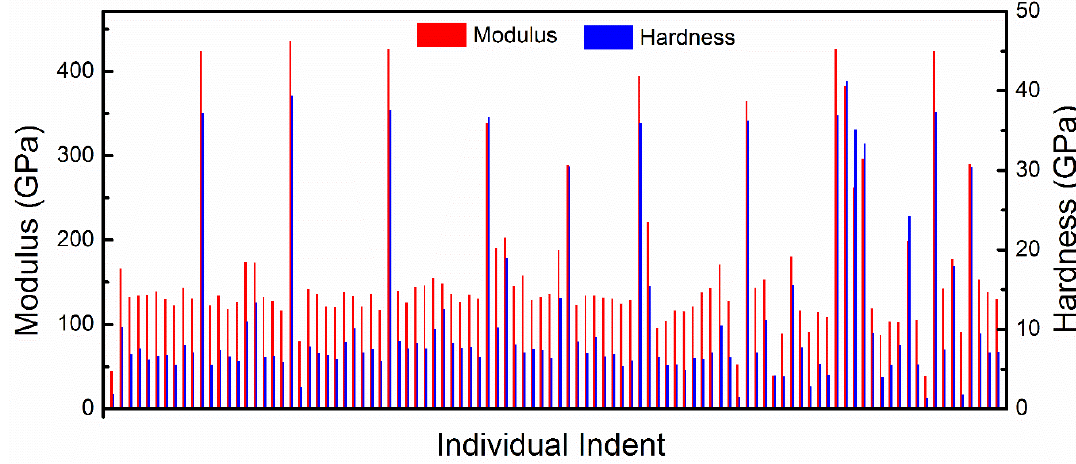
Figure 7. Nanoindentation data collected for the 850 °C sample. The data clearly shows two popu- lations, higher values corresponding to indents in the large grains and lower values to the matrix. Table 1. Nanoindentation data from 850 °C and 1500 °C samples. Condition